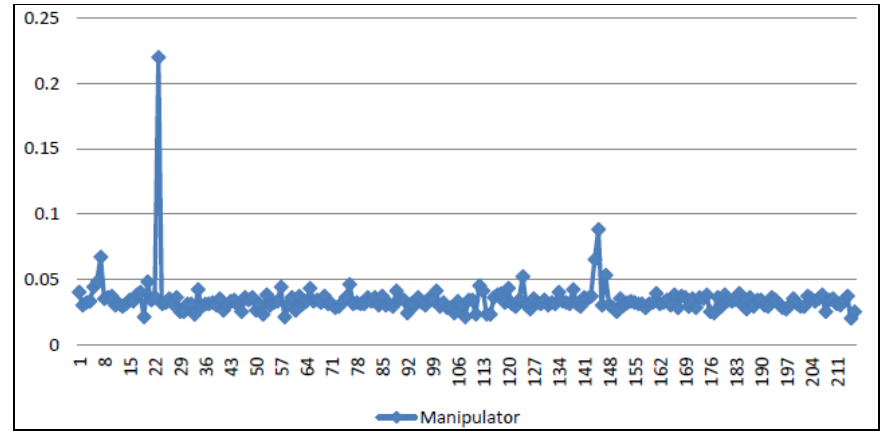
Figure 12. Times of trajectory planning with “RRT connect” for only one robot to weld workpiece 2 in a horizontal position (vertical: planning time in seconds¸ horizontal: number of motion plan executions).